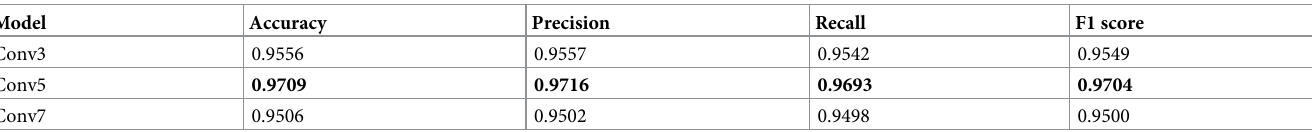
Table 6. Performance comparison of the proposed model with different convolution kernel sizes.